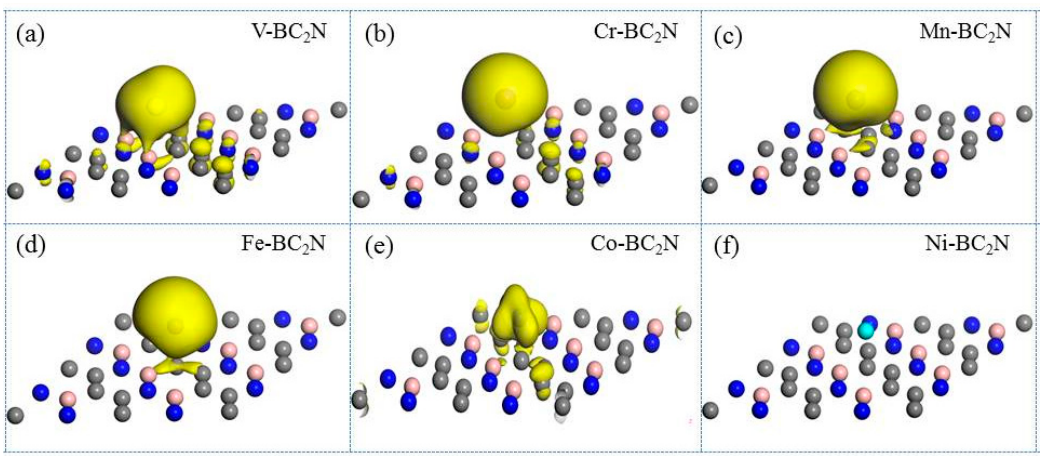
Figure 6. The spin charge density (SCD) of transition metal atoms adsorbed BC 2 N, and ( a )–( f ) represent the SCD of BC 2 N adsorbed by V, Cr, Mn, Fe, Co, and Ni, respectively. This surface value of the charge density is set to 0.003e/Å 3 .